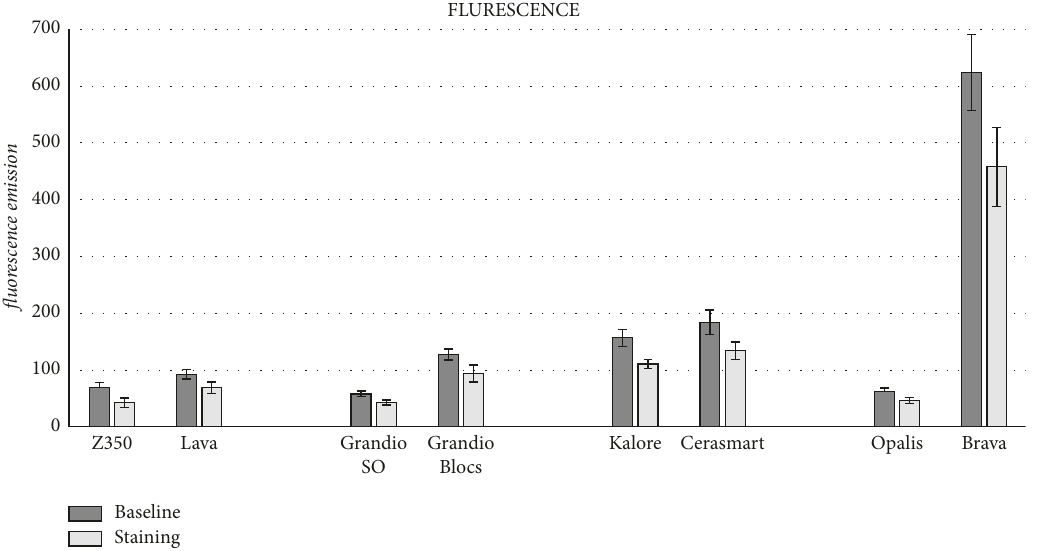
Figure 3: Means (SD) of fluorescence for all groups before and after staining. Table 3: Means (SD) of color change and results of Tukey’s